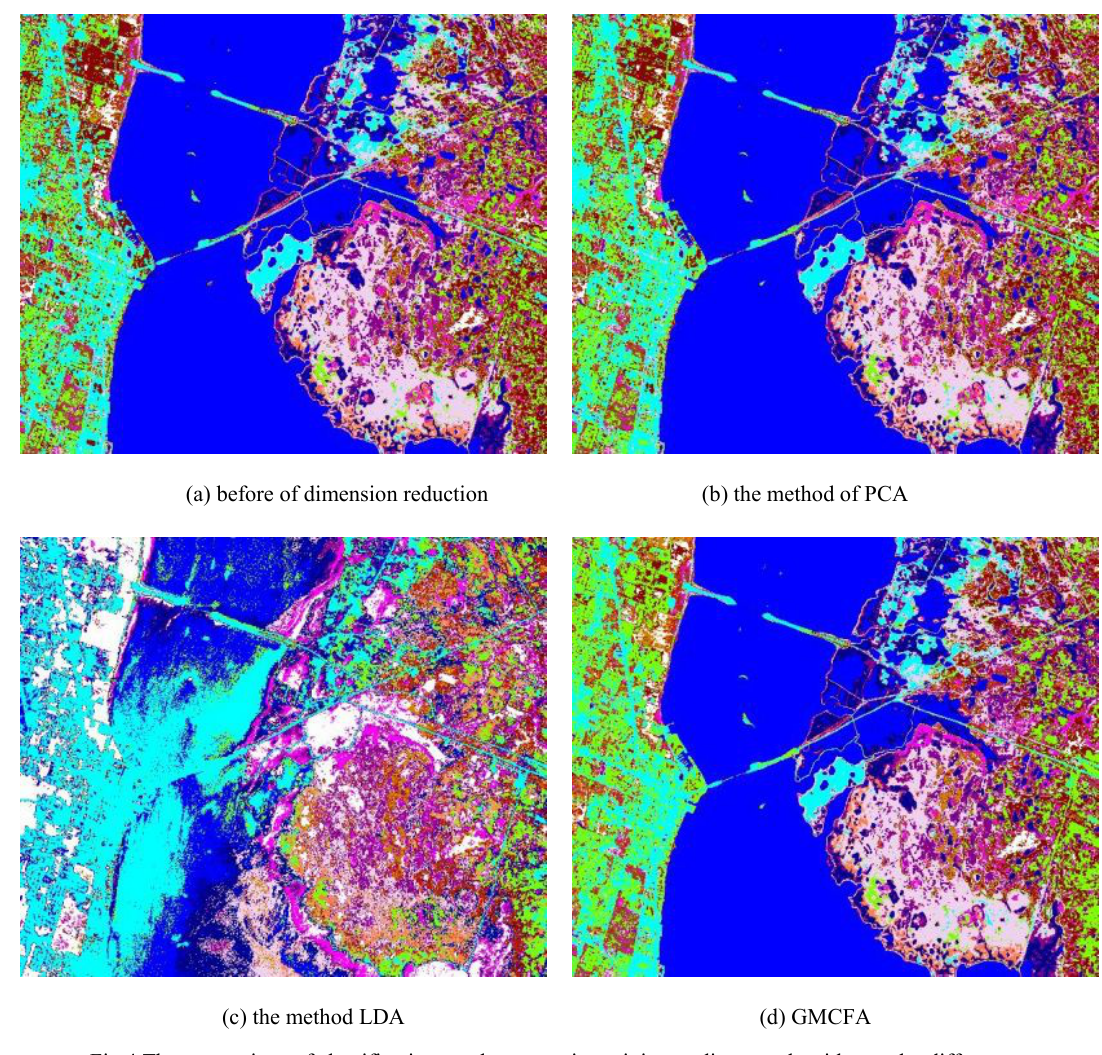
Fig.4 The comparison of classification results map using minimum distance algorithm under different dimension reduction algorithm of AVIRIS